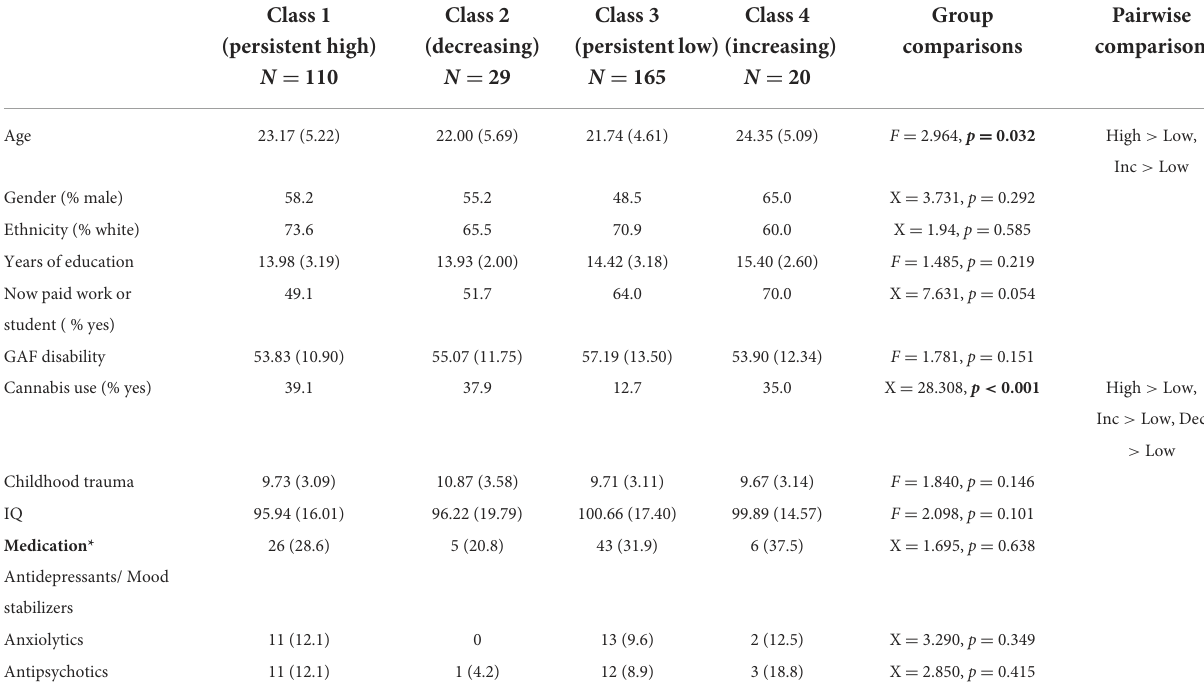
TABLE 2 Baseline information on sociodemographic and clinical variables by trajectory